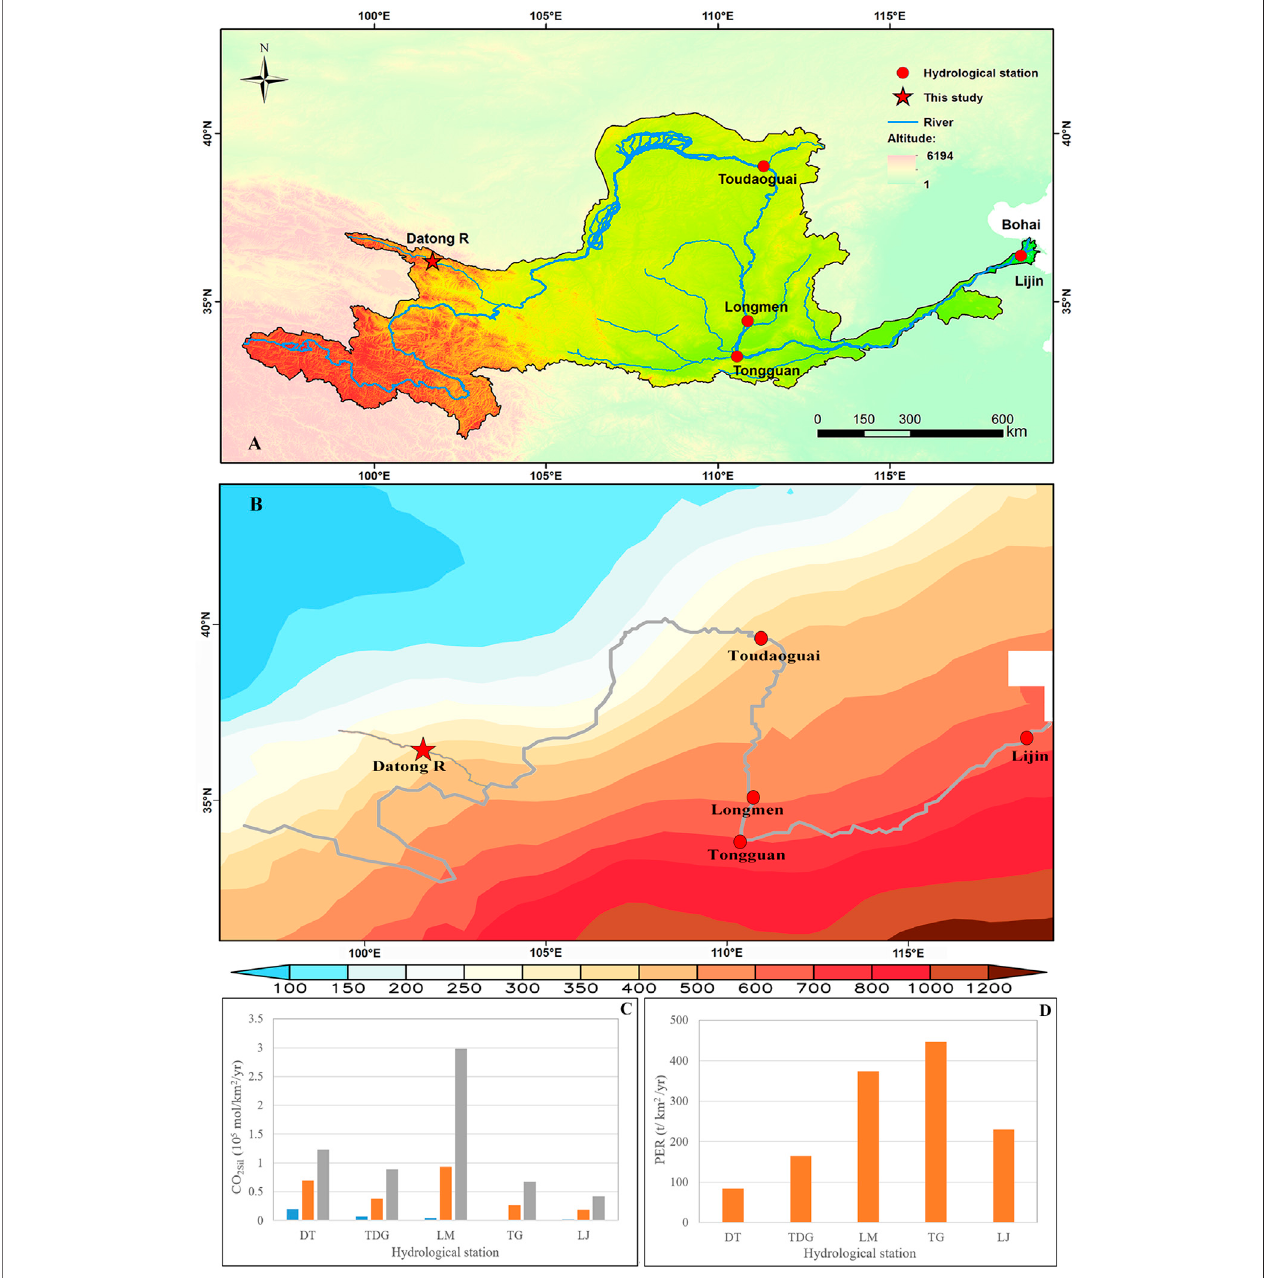
FIGURE 10 | Differences in chemical weathering among stations in the Yellow River basin. The ØCO 2sil overall decreases from the upstream to the downstream of theYellowRiverin (C) ,whereasthephysicalerosionrate(PER)showsanincreasetrendin (D) .TheDatongdata(DT)comefromthisstudy,theLongmendata(LM)come from Zhang et al. (2015), the Toudaoguai (TDG), Tongguan (TG), and Lijin (LJ) data come from Ran et al. (2015). Study areas in this study and the compiled data are shown in (A) . The monthly average precipitation of the Yellow River basin from 2000 to 2020 is shown in (B) .